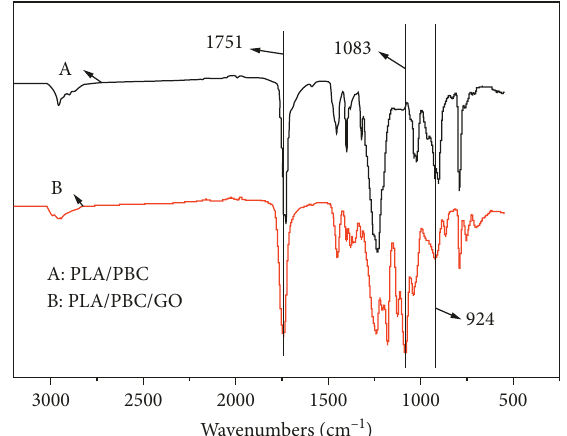
Figure 4: FTIR spectra of PLA/PBC nanofibers and GO-contained PLA/PBC